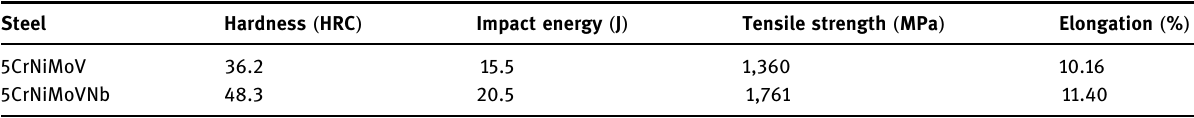
Table 2: Mechanical properties of 5CrNiMoV and 5CrNiMoVNb steel